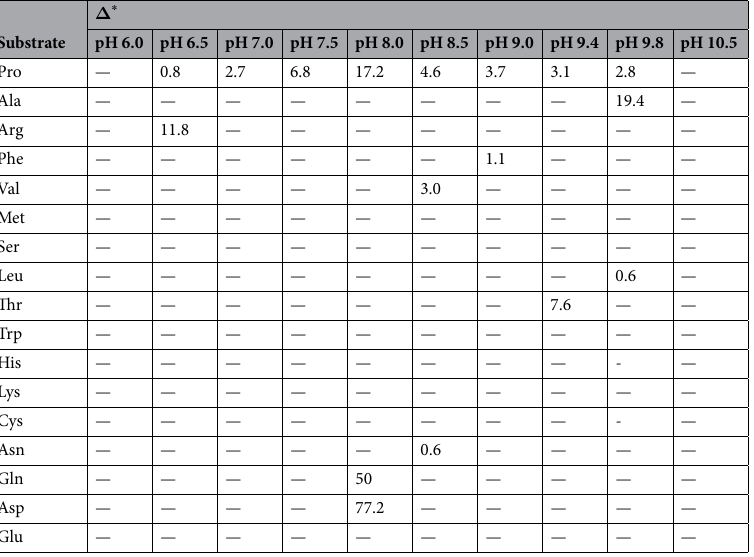
Glu — — — — — — — — — — Table 1. The comparison of activity of DAAO with L- and D-amino acid as substrate. Δ * = (OD 512 (P L-AA )-